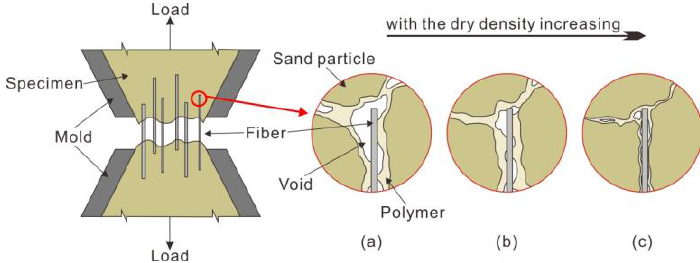
Figure 12. Schematic drawing of microstructure of specimens at dry densities of ( a ) 1.40 g/cm 3 ; ( b ) 1.50 g/cm 3 ; and ( c ) 1.60 g/cm 3 .